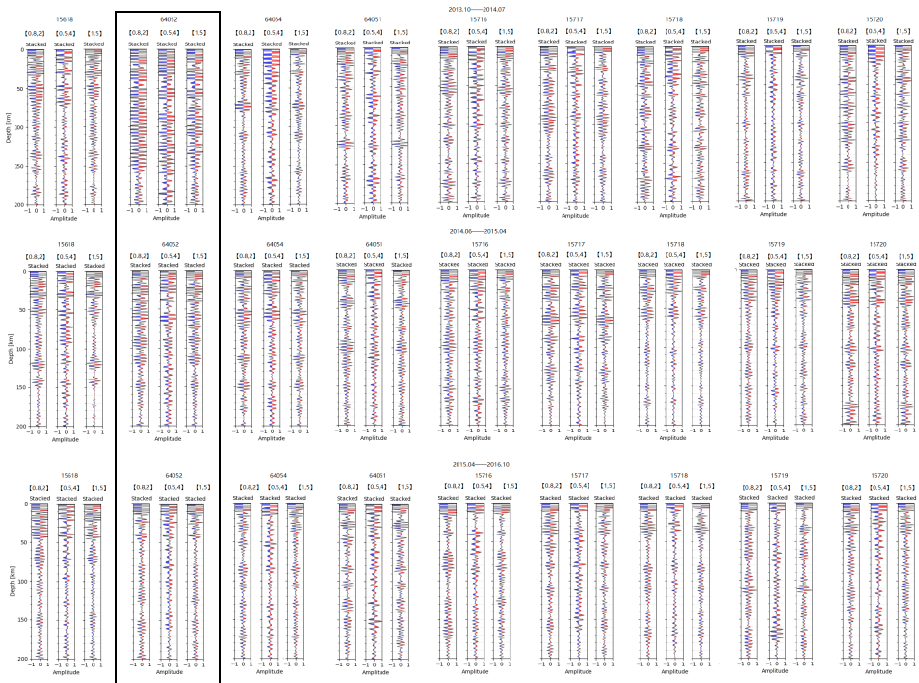
Figure 11. L4 (from left to right: 15673, 15675, 15701, 15706, 15711, 15716, 15721, 15740 and 15735) reflects the depth results of different frequency bands in three time periods from October 2013 to July 2014, June 2014 to April 2015 and April 2015 to October 2016, respectively.